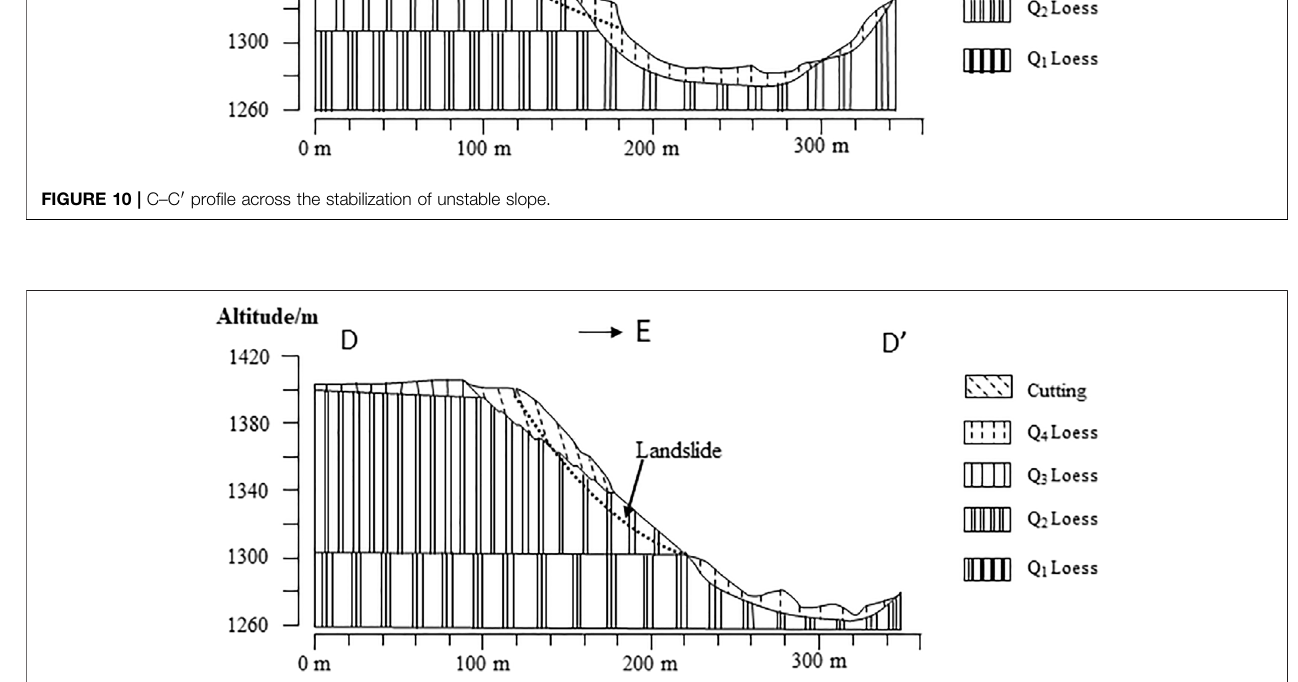
FIGURE 11 | D – D ′ pro fi le across the stabilization of unstable